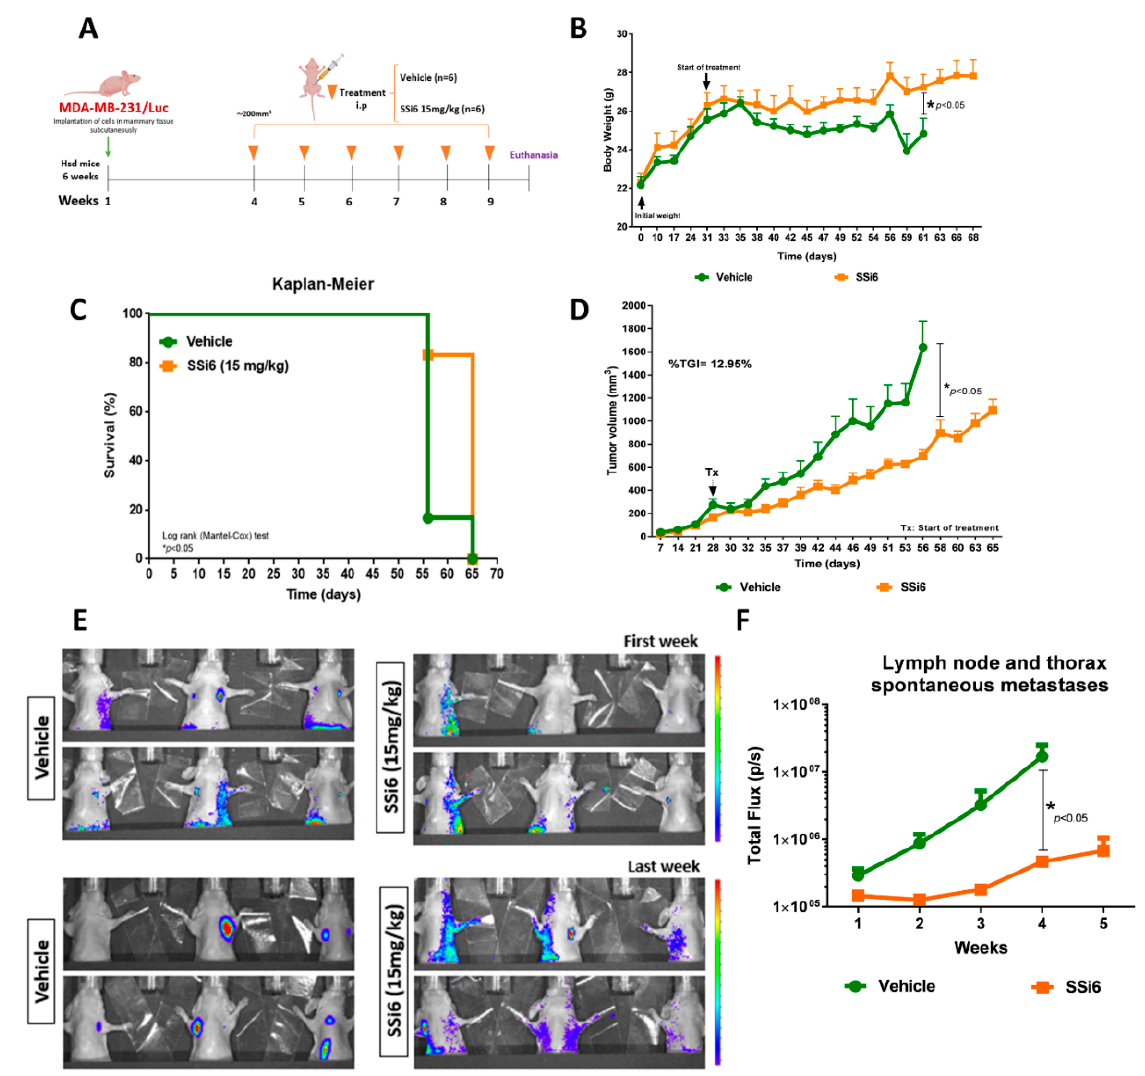
Figure 3. Effects of SSi6 dose on tumor development and axillary lymph node and thorax metastasis in an orthotopic xenograft model. ( A ) MDA-MB-231/Luc cells (1 × 10 6 ) were injected into right and left mammary tissue subcutaneously of each 6-week-old female Athymic Nude mice. When the volume of the tumors reached 200 mm 3 , the mice were randomly divided into two groups (six mice in each group). Then, vehicle (90% physiological serum, 5% DMSO, and 5% Tween80) and SSi6 15 mg/kg were intraperitoneally injected daily in mice. ( B ) Body weight measured thrice a week since initial day from the final of an experiment. * p < 0.05; Student’s t -test. ( C ) Kaplan – Meier survival curve of mice treated with either vehicle or SSi6 15 mg/kg. Survival was calculated from the time of treatment initiation. No statistical differences (n/s, not significant) between the group treated with SSi6 dose and the vehicle group (log-rank Mantel-Cox test). ( D ) The volume of each tumor was measured three times a week for 65 days. Tumor growth inhibition (TGI) was calculated Tf final time point (volume) and T0 initial time point (volume) of SSi6 and vehicle group. TGI exerted by SSi6 12.95%. ( E ) Representative images of vehicle and SSi6 group with lymph node and lung metastases at first week until last week of treatment. ( F ) Quantification of lymph node and thorax spontaneous metastases as measured by total bioluminescence flux in photons/seconds.